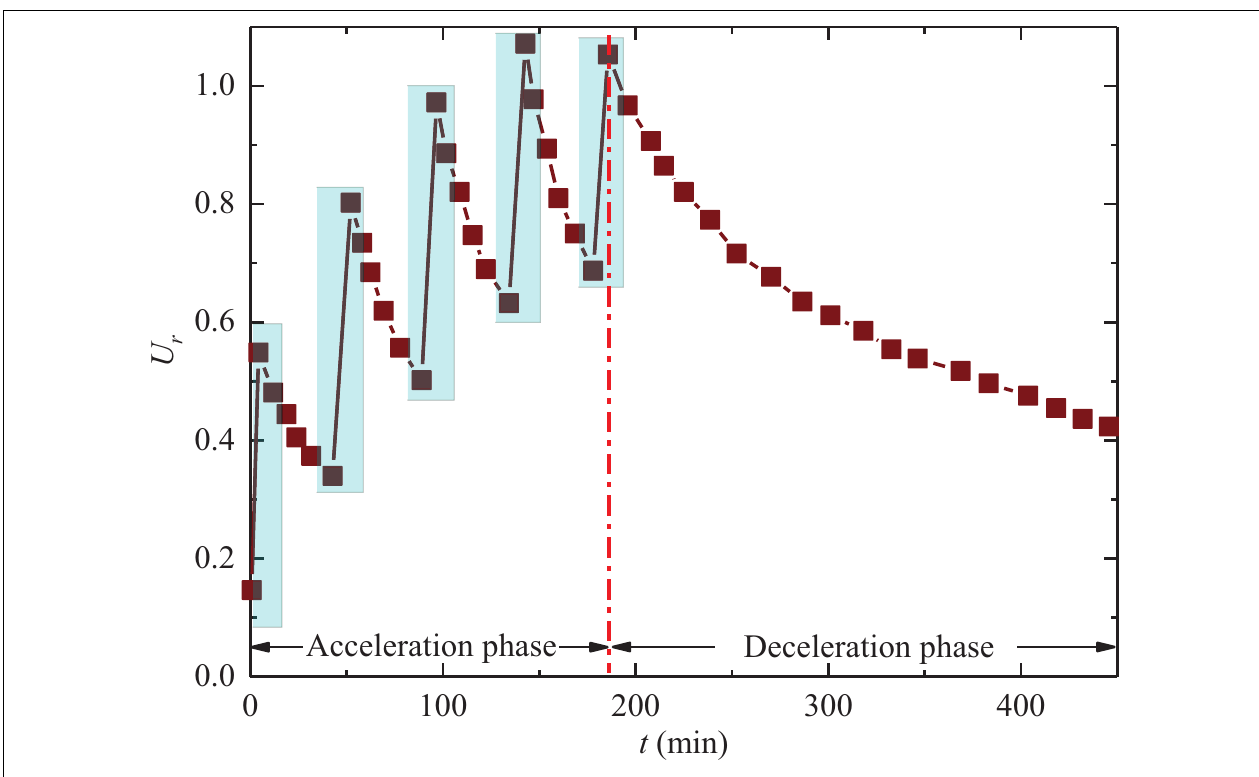
FIGURE 10 | Schematic diagram of relative excess pore pressure change under grain disturbance.